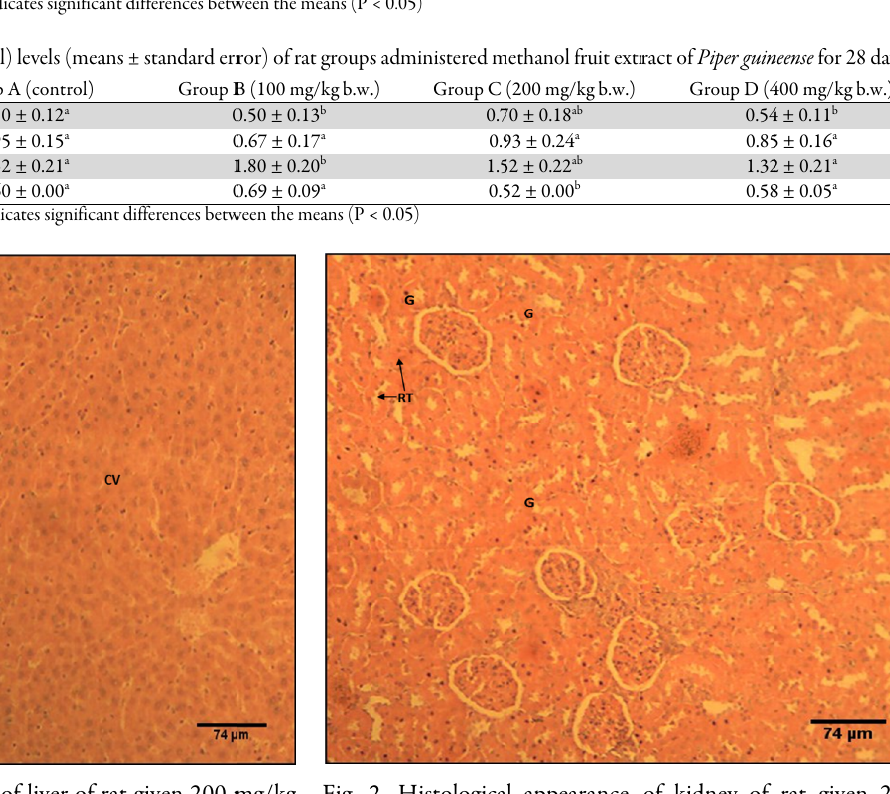
Fig. 2. Histological appearance of kidney of rat given 200 2. Histological appearance of kidney of rat given 200 mg/kg body weight of methanol fruit extract of mg/kg body weight of methanol fruit extract of orally for 28 days, showing no obvious lesions. Note the glomeruli (G) amidst